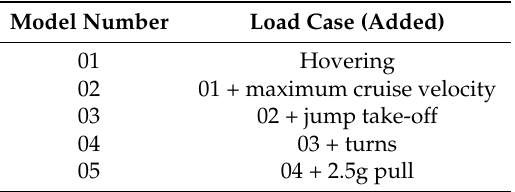
Table 11. Load case description.